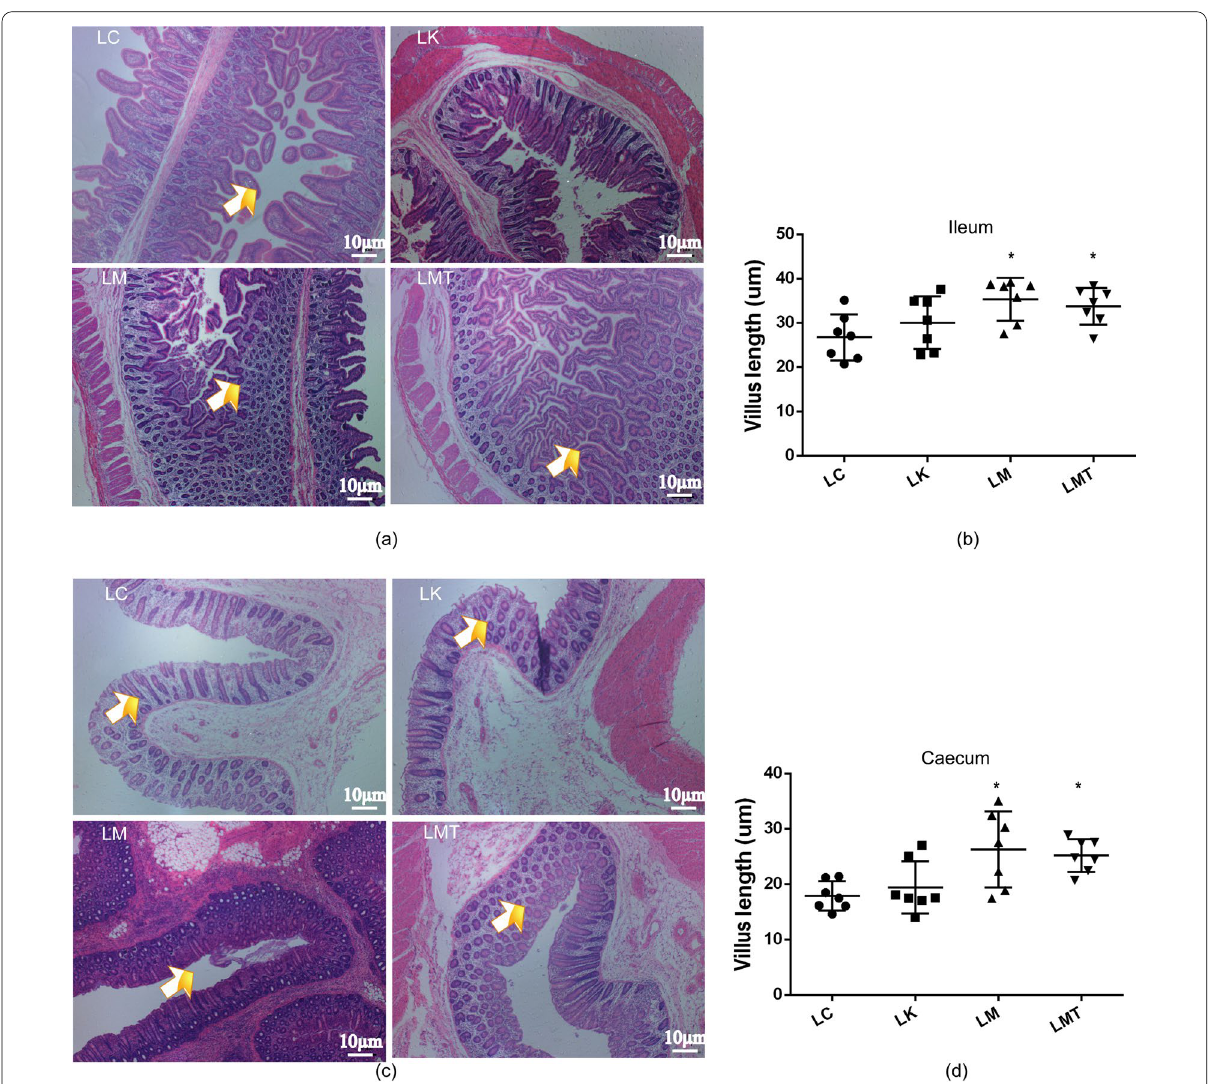
Fig. 2 Variation in pH of the gastrointestinal content of weaned piglets on day 28. a pH levels of succus gastricus, b pH of rectal content, c pH of cecal content, d pH of ileal content, e pH of duodenal content, f pH of jejunal content, and g pH of colonic content ( *p < 0.05